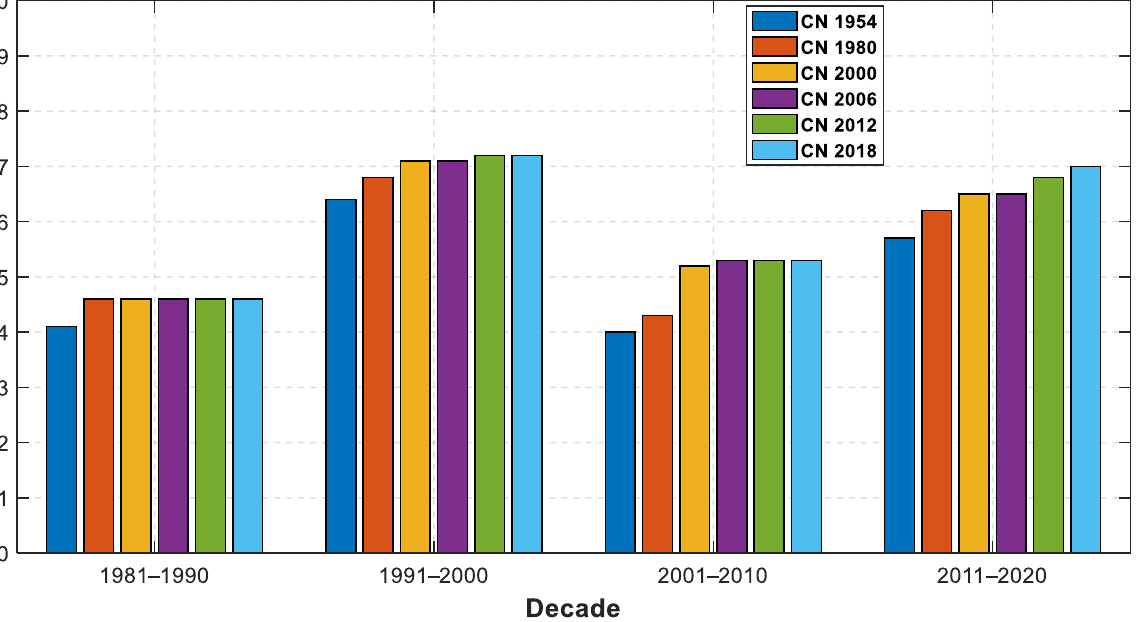
Figure 12. Average decade number of annual exceedance events the 35 m 3 /s discharge threshold at different CN conditions over the section of the Seveso River basin closed at Bovisio-Masciago.